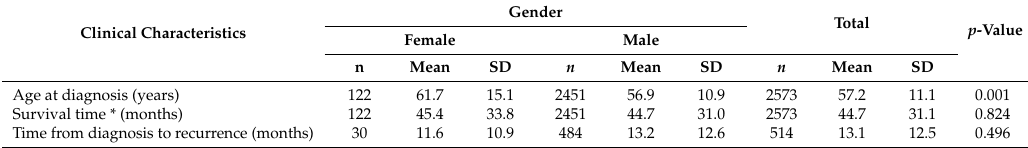
Table 1. Age at diagnosis, survival time (follow-up duration was from index data to 30 June 2019), and interval from diagnosis to recurrence in all patients with oral squamous cell carcinoma (OSCC); p- value was tested by Student’s t -test.